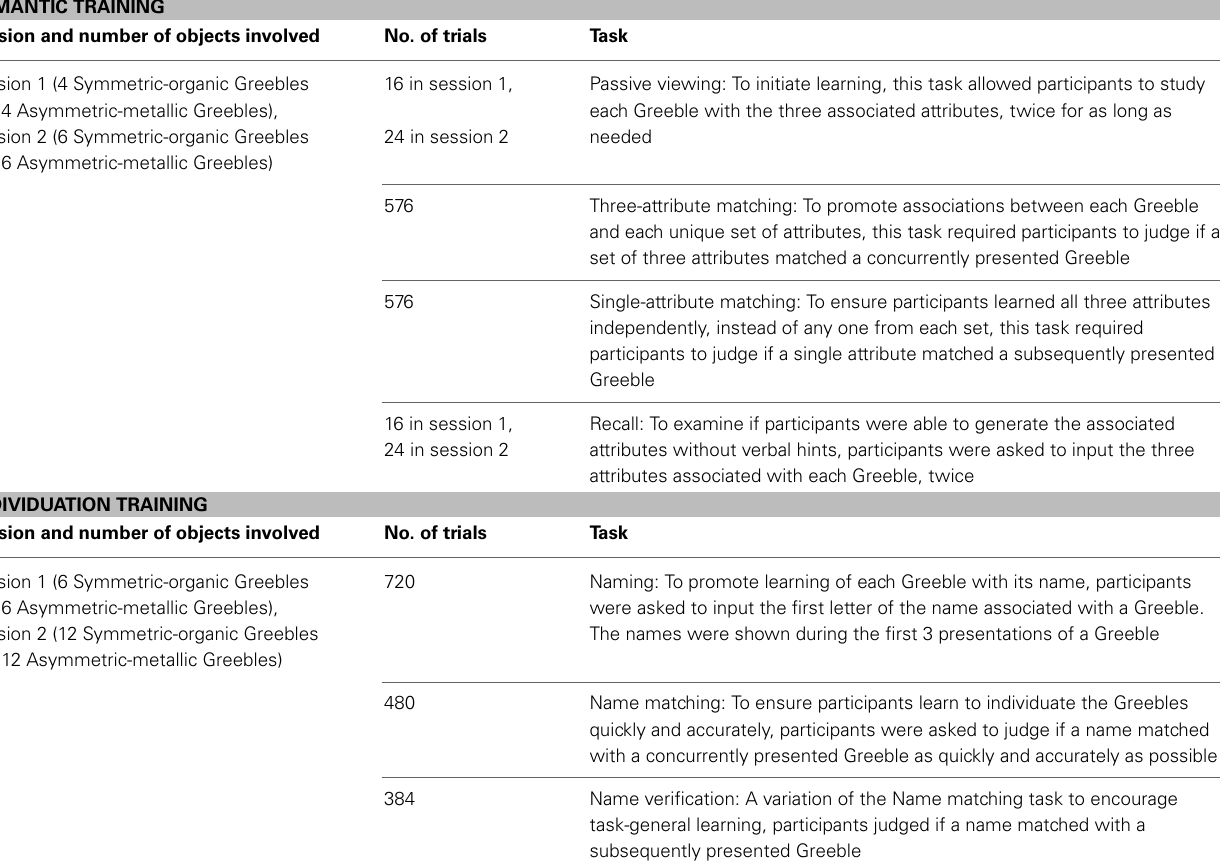
Table 1 | Task details of the two-stage training